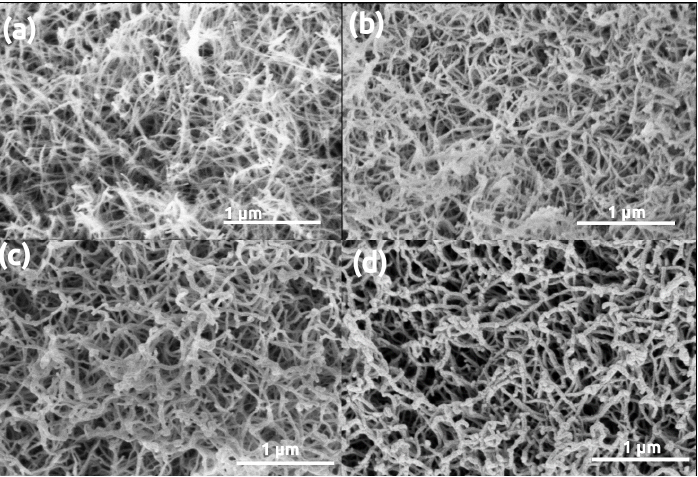
Figure 5. LVSEM images of polyimide aerogel samples. ( a ) Pristine, uncoated. ( b – d ) Sputter coated with 5 nm, 16 nm, 32 nm thick Au layers, respectively.